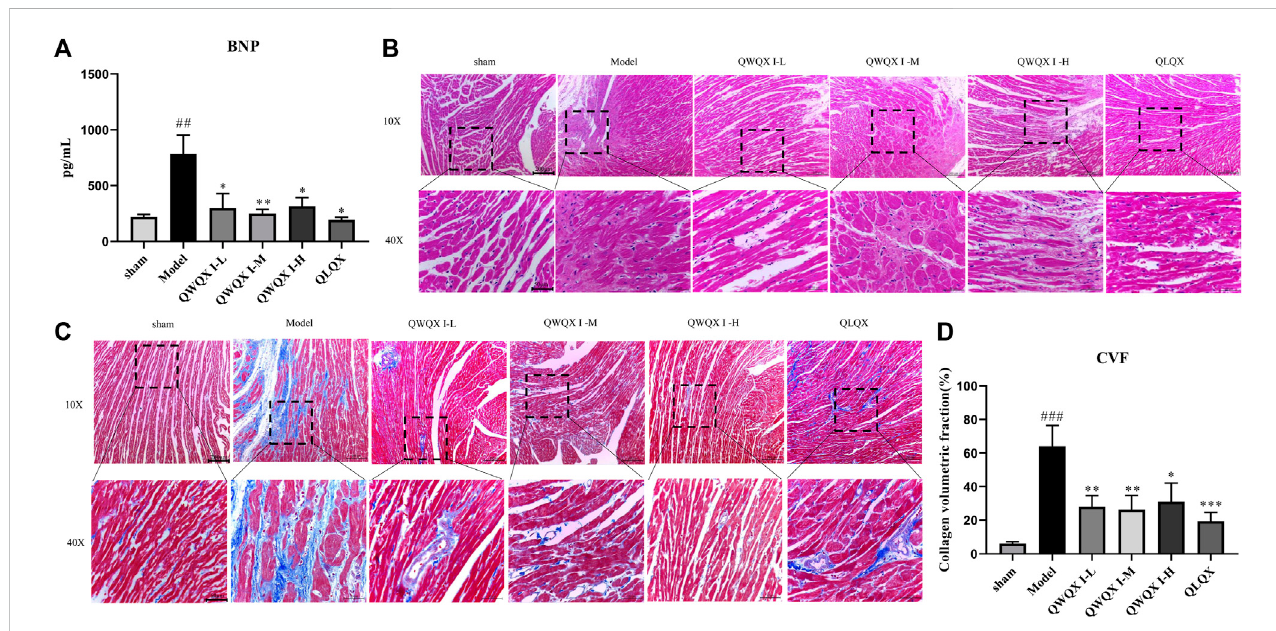
FIGURE 3 Effect of QWQX I on histopathological changes in CHF rats. (A) Plasma level of BNP. (B) Images of HE staining. (C) Images of Masson staining. (D) Quantitative analysis of CVF. Data are expressed as the Mean ± SEM. ### p < 0.001, the Model group vs. the sham group; * p < 0.05, ** p < 0.01, *** p < 0.001, drug treatment group vs. the Model